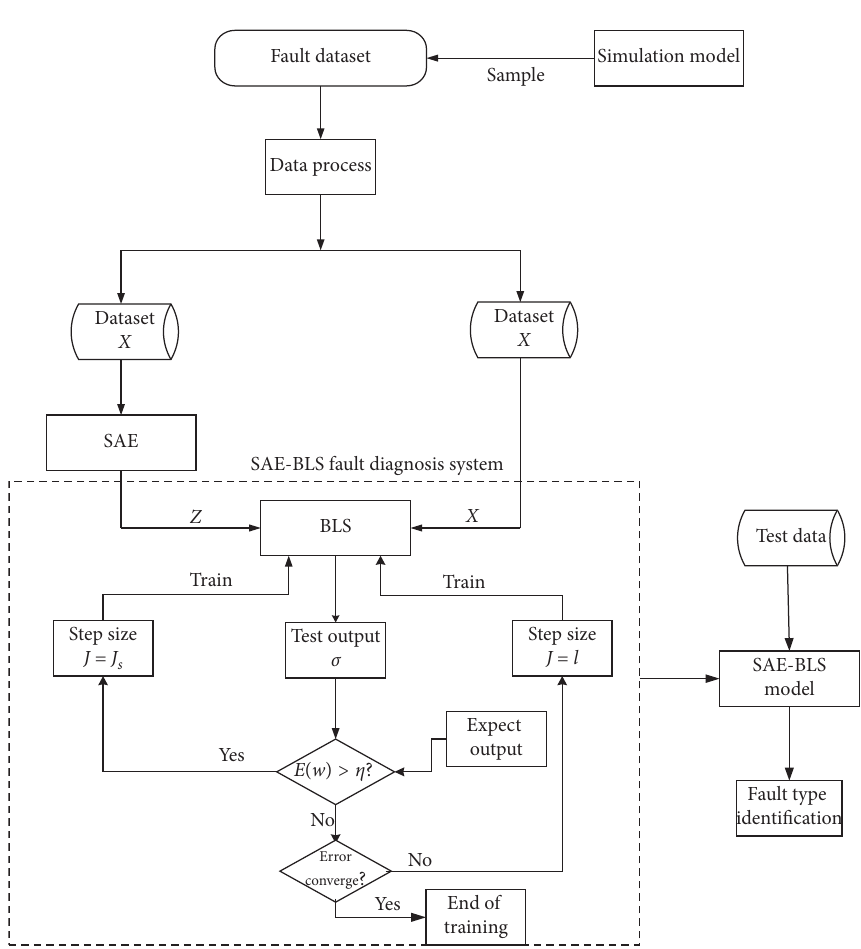
Figure 6: Flowchart based on SAE-BLS fault diagnosis